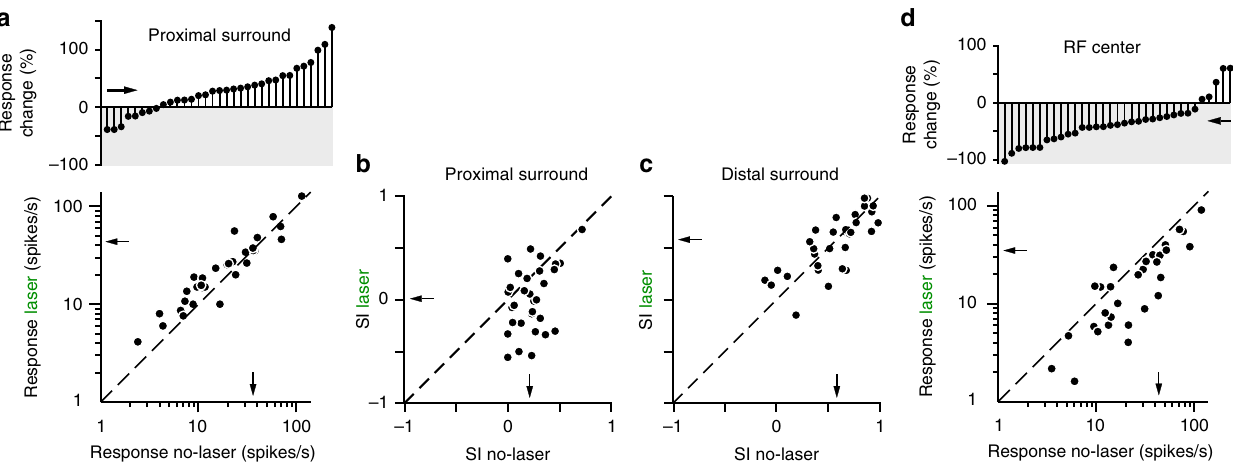
Fig. 3 V2 feedback controls response amplitude in the sRF and proximal surround. a , b Changes in proximal surround-suppression with V2 feedback inactivated. a Bottom: response with and without laser for stimuli involving the sRF and proximal surround (i.e., stimulus size corresponding to the peak of the laser-on curve). Top: Cell-by-cell percent response change caused by laser stimulation, for stimuli involving the sRF and proximal surround. Downward and upward stem: decreased and increased response, respectively. b Suppression Index (SI; see Methods) with and without laser for stimuli extending into the proximal surround. SI = 1 indicates maximal suppression, SI = 0 indicates no suppression, and negative SI values indicate facilitation. c Same as b but for stimuli extending into the distal surround (largest stimulus used). d Bottom: response with and without laser for stimuli matched in size to the sRF diameter (i.e., the stimulus diameter at the peak of the empirically measured, spatial-summation curve in the no-laser condition). Top: Cell-by-cell percent response change caused by laser stimulation for stimuli matched to the sRF diameter. Arrows: means. One data point with very high fi ring rate in the scatterplots of panels a – d was removed for visualization purpose, but it was included in the analysis. Dashed line in a – d : unity